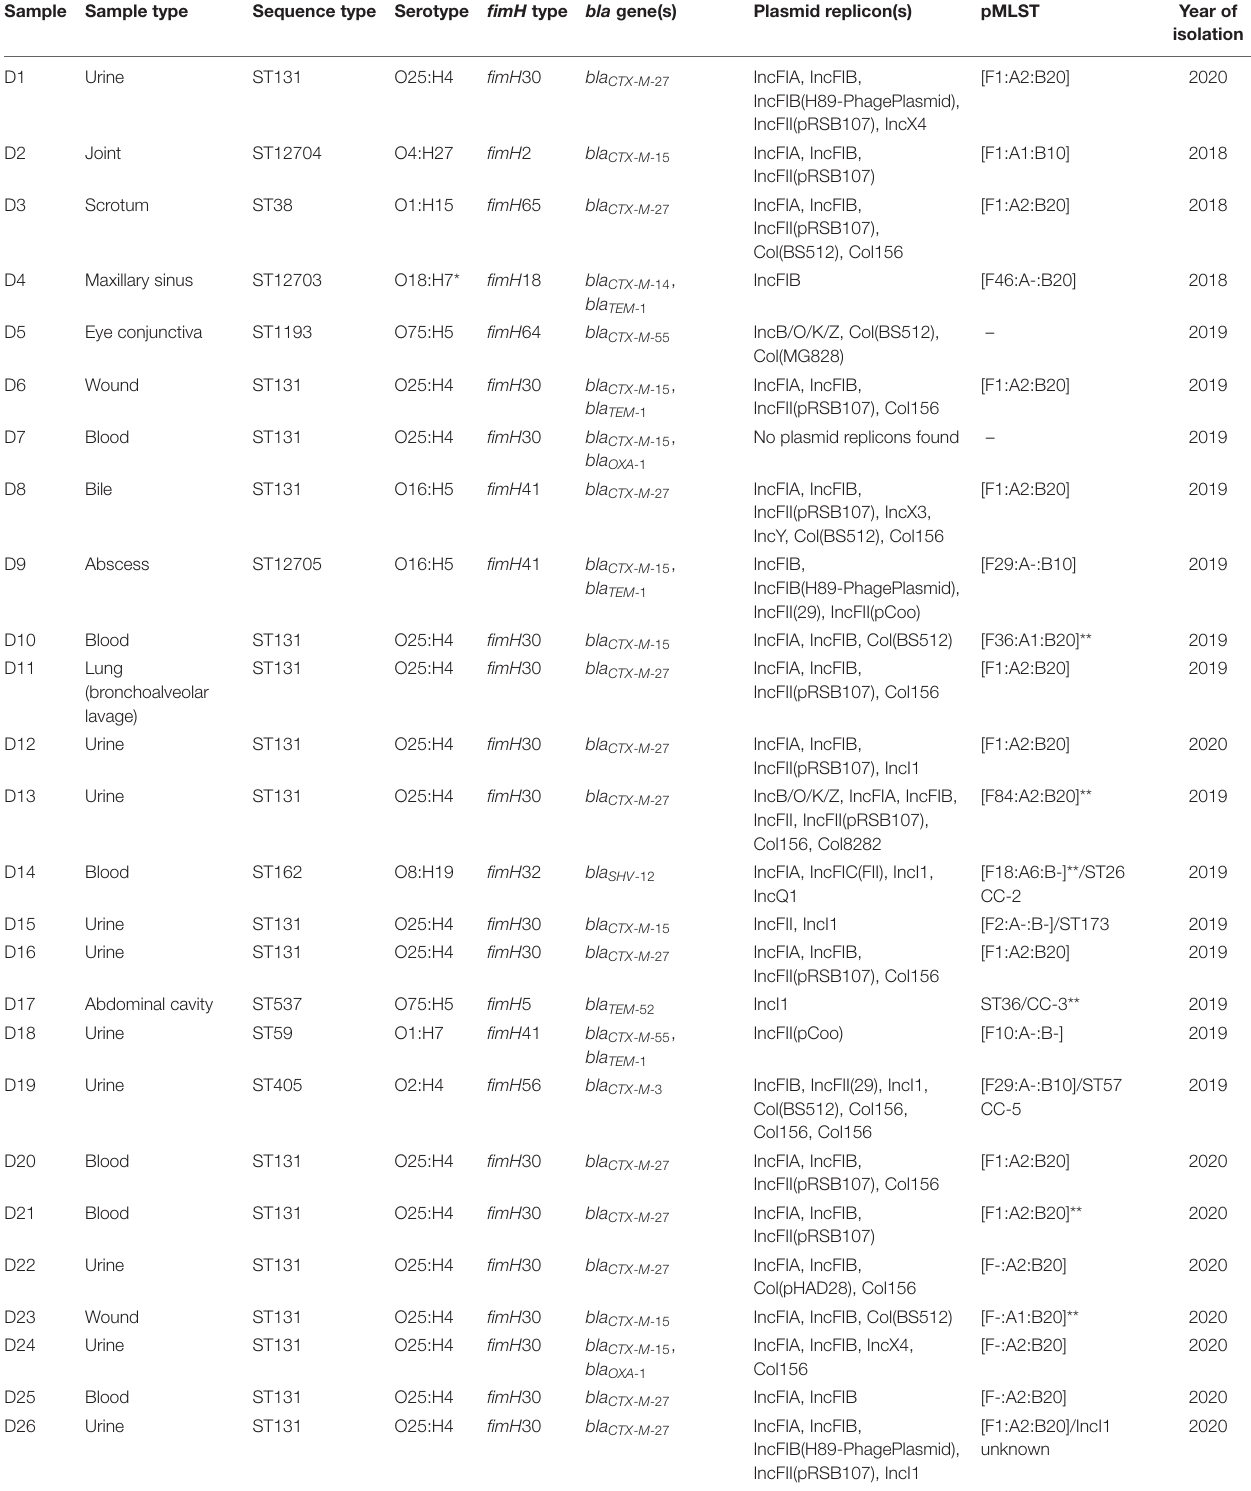
TABLE 1 | Genomic characterization of 30 ESBL-producing Escherichia coli isolates obtained from human clinical samples in the Eastern Finland healthcare district during 2018–2020. Sample Sample